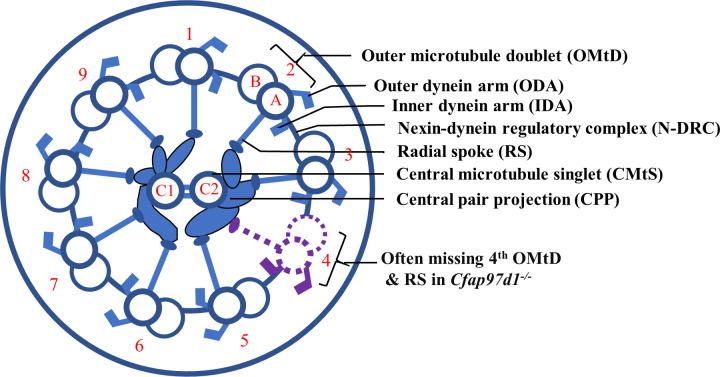
Schematic representation of the defects in axoneme caused by Cfap97d1 deletion.Outer microtubule doublet (OMtD) composed of A and B tubules and radial spokes (RS) (blue) are labeled 1–9 (red) with the frequently missing doublet 4 and adjacent radial spoke indicated by purple dashed lines. The outer (ODA) and inner dynein arms (IDA) are attached to the A tubule of OMtD. All OMtDs are interconnected by the nexin-dynein regulatory complex (N-DRC). Central microtubule singlets (CMtS) are marked C1 and C2 with neighboring central pair projections (CPP).